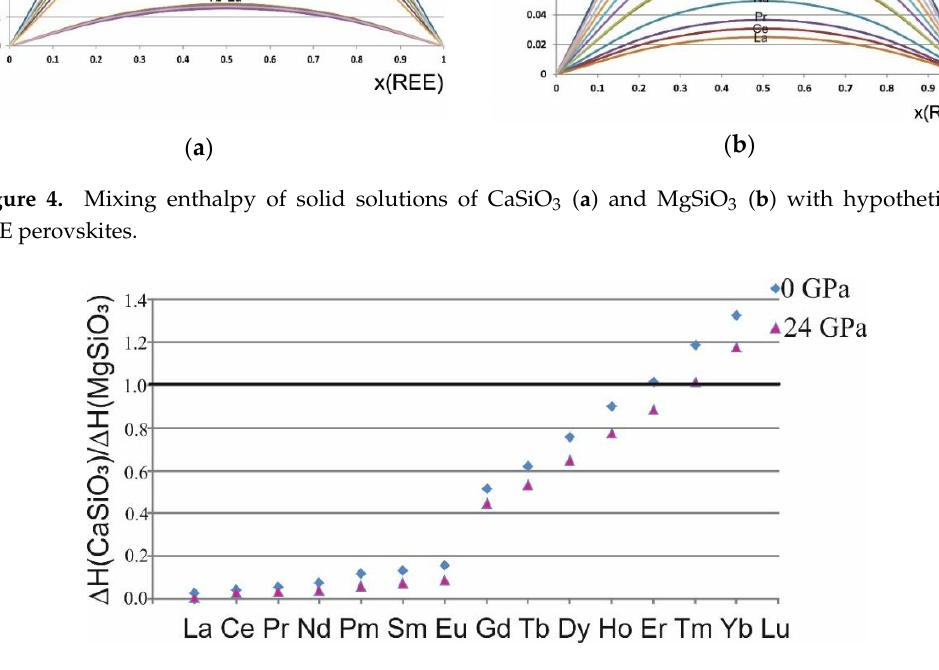
Figure 5. Calculated ratios of mixing enthalpies of CaSiO 3 -perovskite and bridgmanite at 0 and 24 GPa illustrating an increase in the CaPrv/Brd REE partitioning coefficients with pressure.